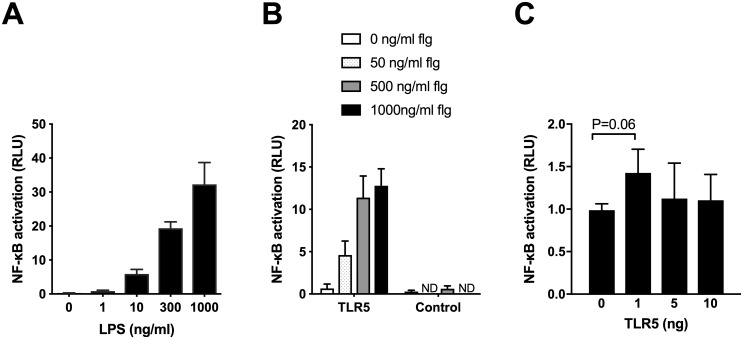
TLR5 does not alter TLR4-dependent NF-κB activity in transfected HEK293 cells.HEK293 cells stably expressing TLR4/MD-2/CD14 were transiently transfected with NF-κB-dependent firefly ELAM luciferase, and Renilla luciferase to permit detection of NF-κB activation by luciferase (ratio of ELAM/Renilla luciferase signal expressed as relative light units). A: Cells were stimulated with E. coli LPS for 4 hours. B: Cells were transfected with 5 ng TLR5 and 5 ng of pEF6 (empty vector), and stimulated with Salmonella Typhimurium flagellin at various concentrations for 4 hours. For both A and B, mean values ± standard deviations of triplicate conditions are displayed. Representative examples from four independent experiments are shown. C: Cells were transfected with increasing amounts of TLR5 and stimulated with 10 ng/mL E. coli LPS for 4 hours. Total DNA transfected was kept constant by the addition of pEF6 (empty vector). Data shown are the mean values ± standard deviations of three independent experiments normalized to relative light units for 0 ng TLR5 transfection.